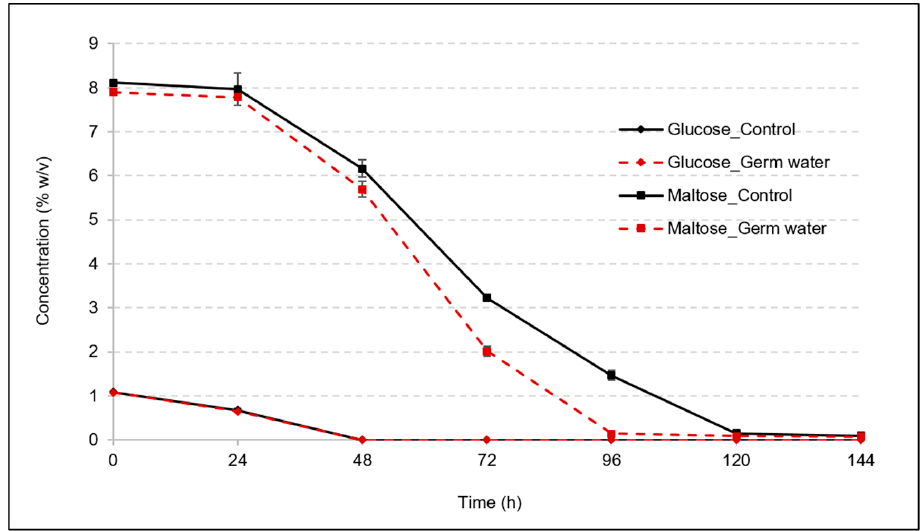
Figure 3. Glucose and maltose concentration during fermentation without (control) and with addition of germ soak water.